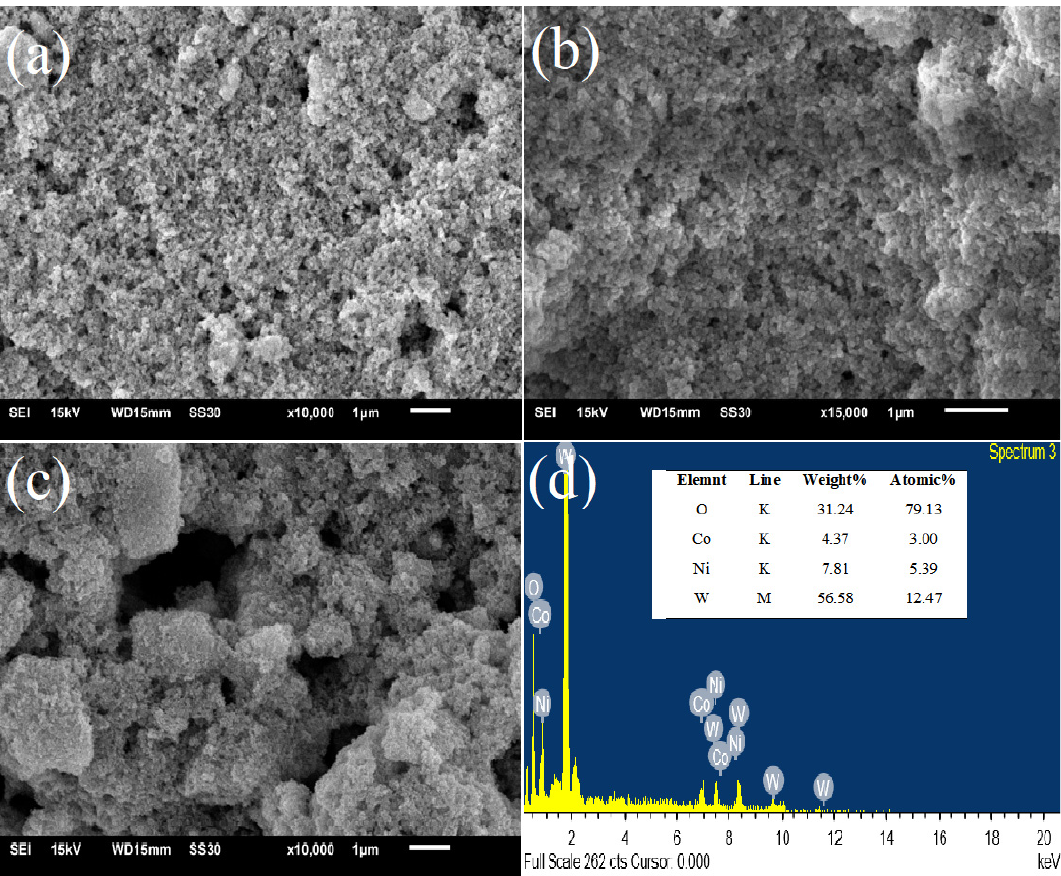
Figure 3. SEM images of the metal tungstate ( a ) NiWO 4; ( b ) CoWO 4 , mix metal tungstate ( c ) NiWO 4 /CoWO 4 NC; ( d ) EDX of NiWO 4 /CoWO 4 NC.